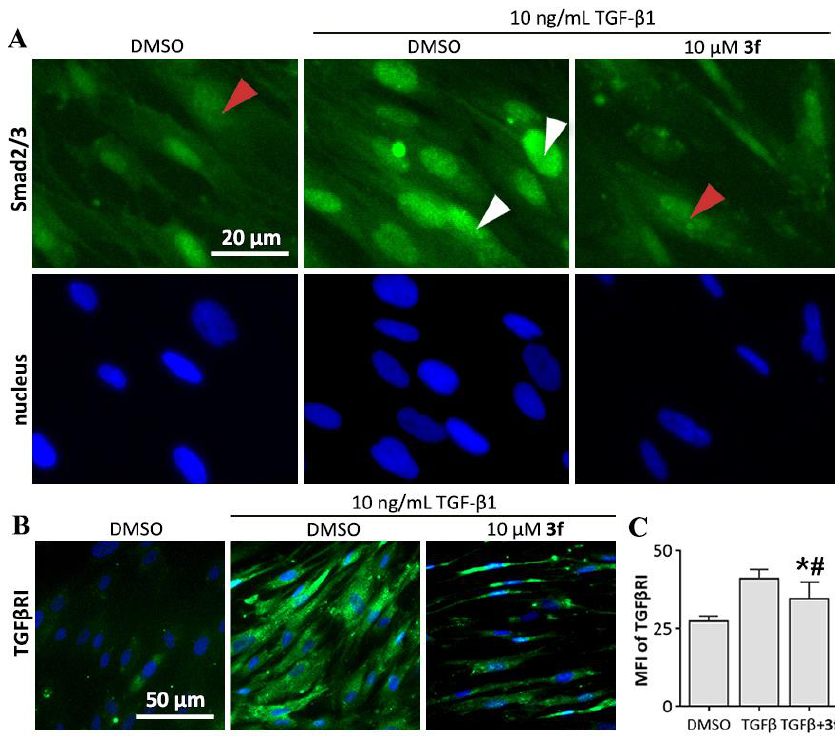
Figure 6. Effect of compound 3f against small mothers against decapentaplegic homologs (Smad) signaling. ( A ) 3f inhibited cytoplasm to nuclear translocation of Smad2/3 in MRC-5 cells. Immunofluorescence staining using an antibody recognizing total Smad2 and Smad3. Red arrows indicate the localization of Smad2/3 in cytoplasm, and white arrows indicate the nuclear localization of Smad2/3; ( B ) 3f inhibited TGF- β 1-induced upregulation of expression level of TGF- β receptor type I (TGF β RI); ( C ) mean fluorescence intensity (MFI) of TGF β RI, presented as mean ± SD of three individual experiments. * p < 0.05 vs. TGF β group, # p < 0.05 vs. DMSO group.